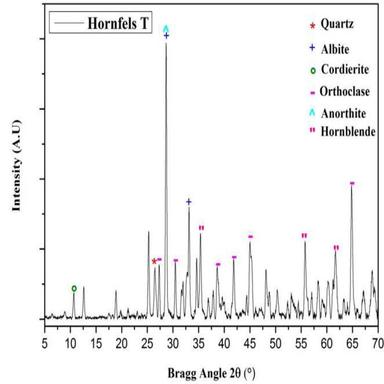
Experimental X-ray powder diffraction profile of HT at room temperature.